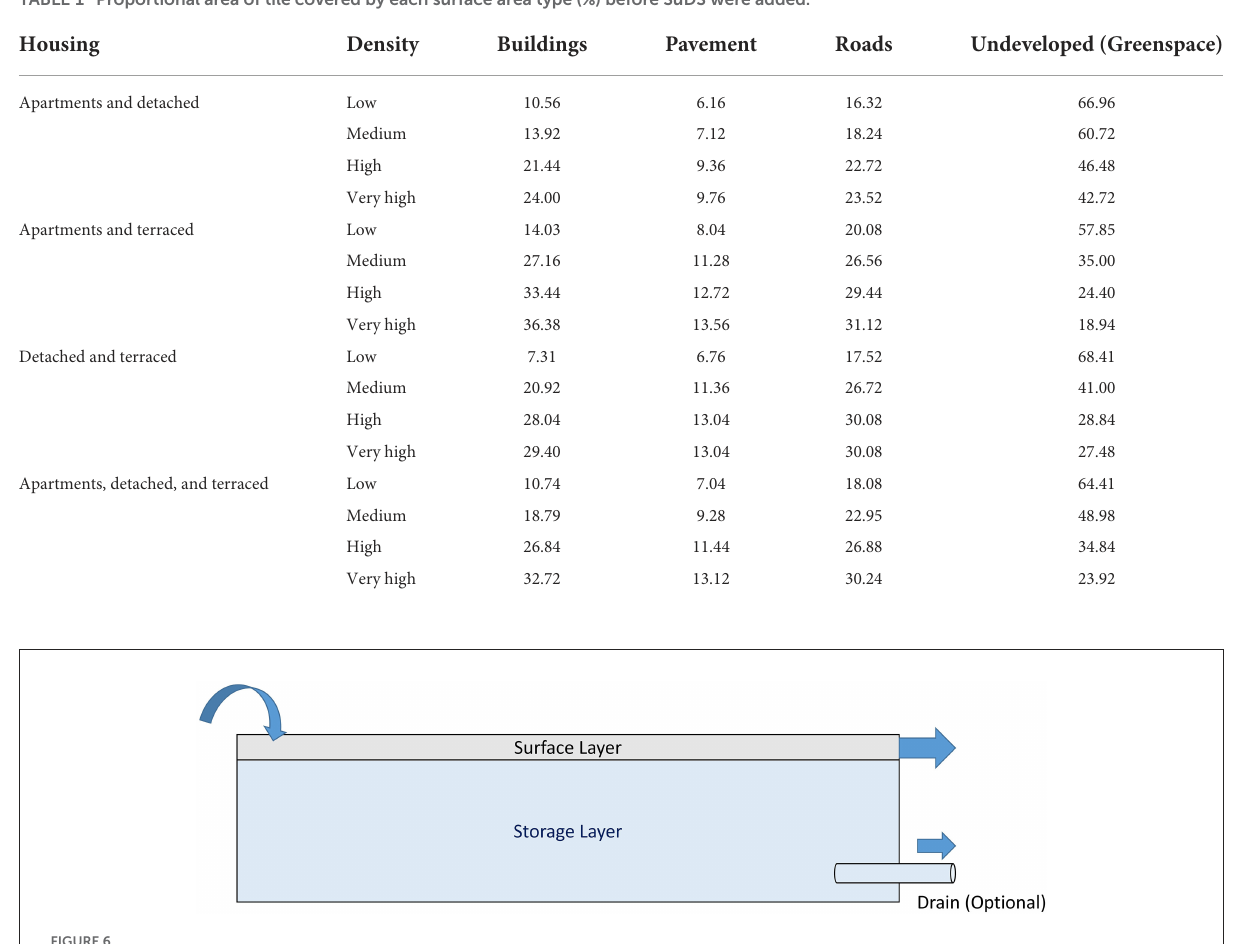
TABLE 1 Proportional area of tile covered by each surface area type (%) before SuDS were added.